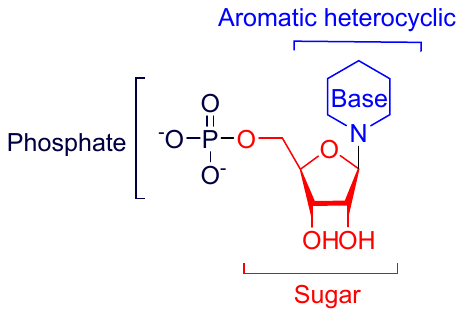
Figure 2. Areas for modification on nucleoside analogues.